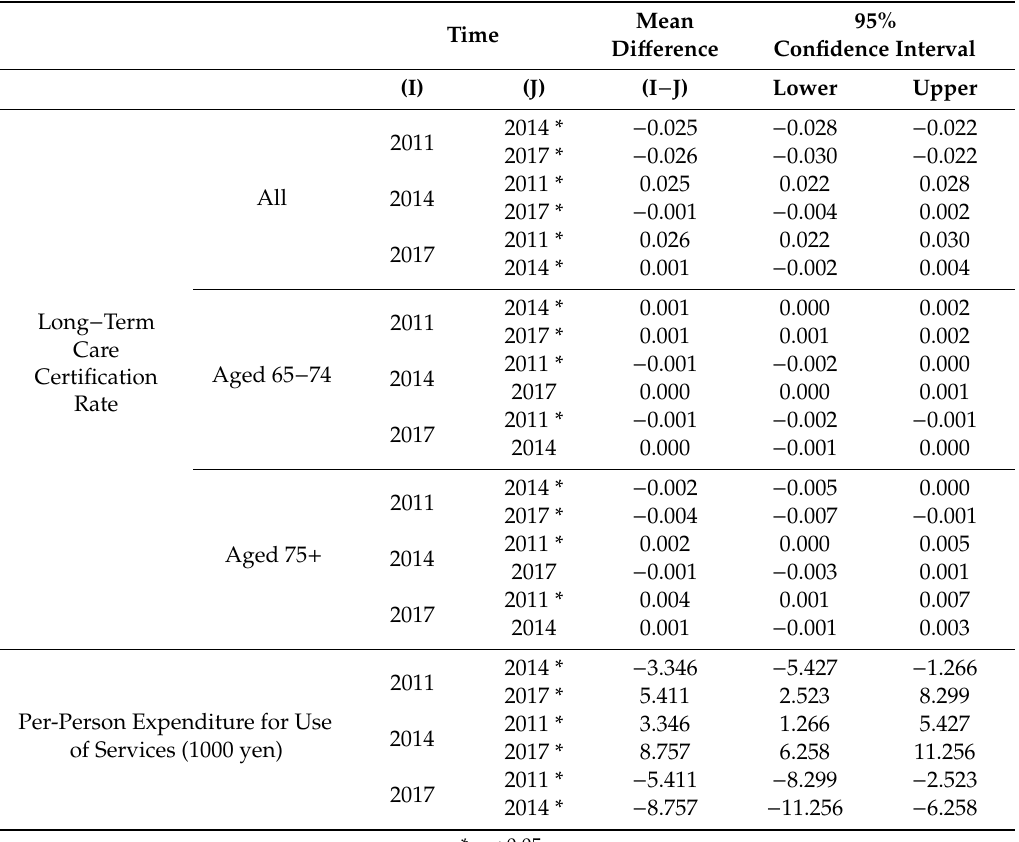
Table 3. The result of post hoc test of